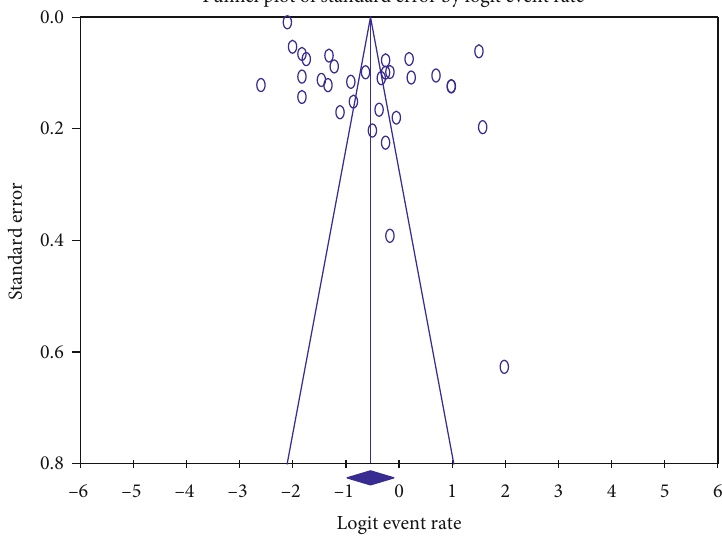
Figure 3: Funnel plot for publication bias of the included